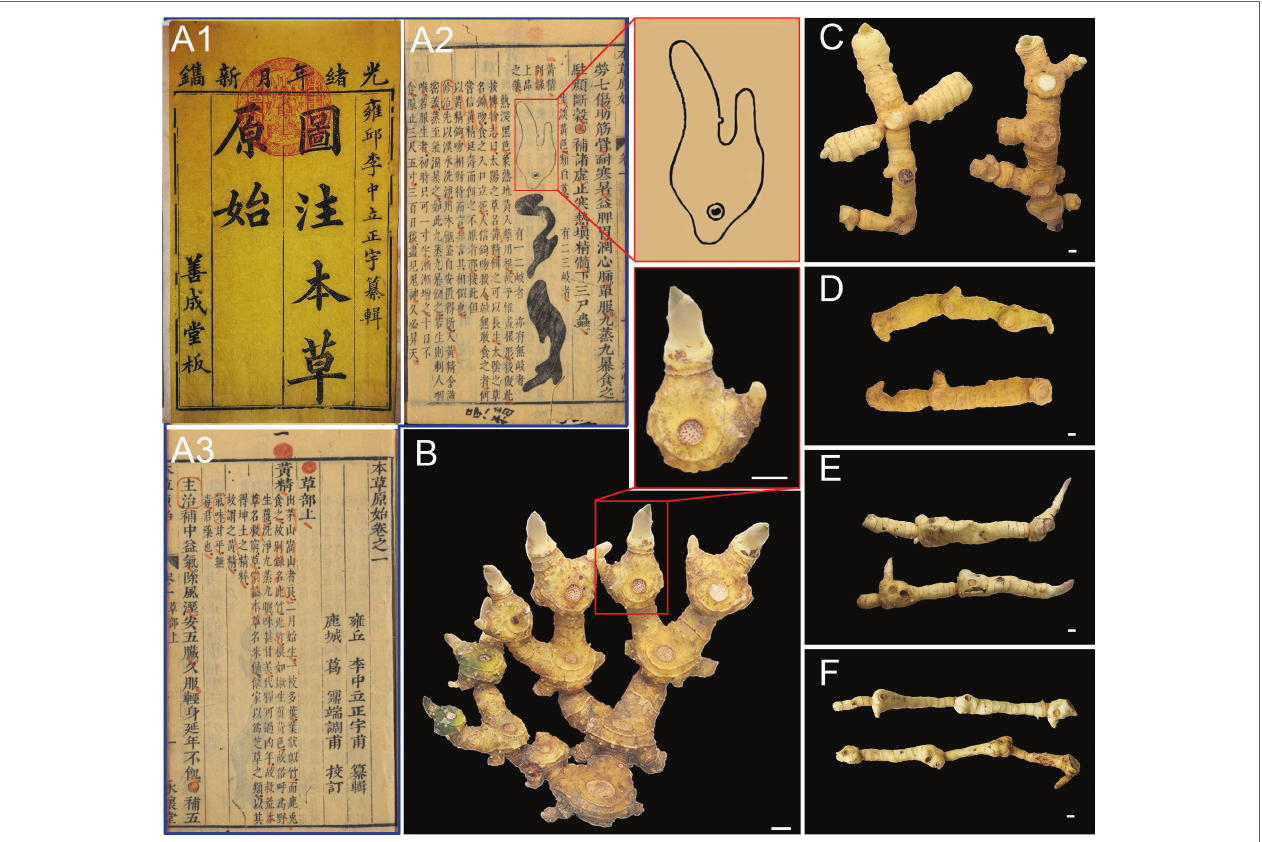
FIGURE 1 | Huangjing recorded in Ben Cao Yuan Shi 本草原始 (A1 - A3) and five types of Huangjing (B - F) . (A1) Shan Cheng Tang Edition, (A2 , A3) Yong Huai Tang Edition, Image courtesy of Chinese—Japanese Library, Harvard University, (B) “ BaiJi -type” Polygonati rhizoma, (C) “ Jiang -type” Polygonati rhizoma, (D) “ Cylinder -type” Polygonati rhizoma, (E) “ JiTou -type” Polygonati rhizoma, and (F) atypical “ JiTou -type” Polygonati rhizoma. Scale bar = 1